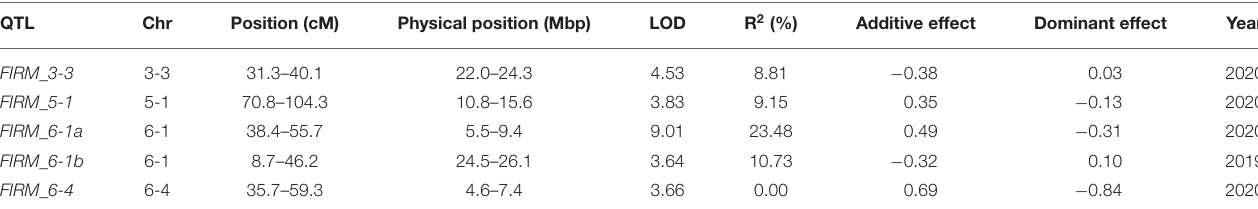
TABLE 2 | QTLs for fruit firmness detected in 2